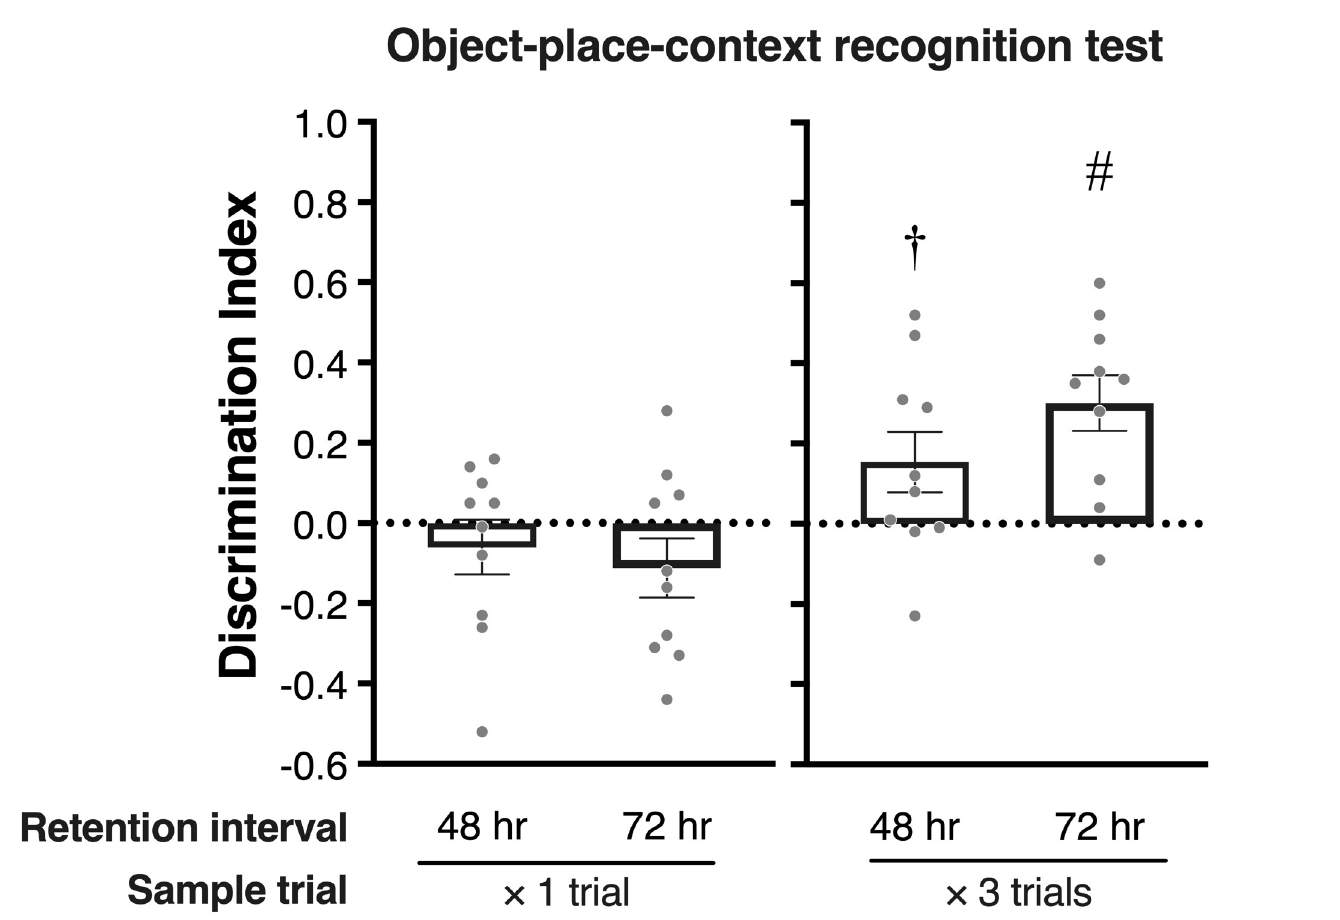
Fig 4. Mean ( ± SEM) discrimination index in test phase of OPC recognition test in experiment 2–1 and 2–2. The horizontal dotted line indicates chance level (0). # p < .05, † p < .10 compared to chance level using one-sample t